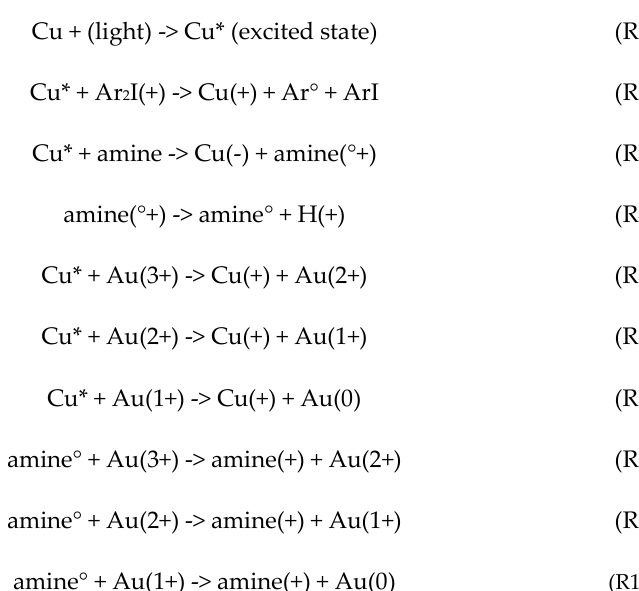
Scheme 1. A proposed kinetics for a 3-component system of G1/Iod/amine in gold chloride